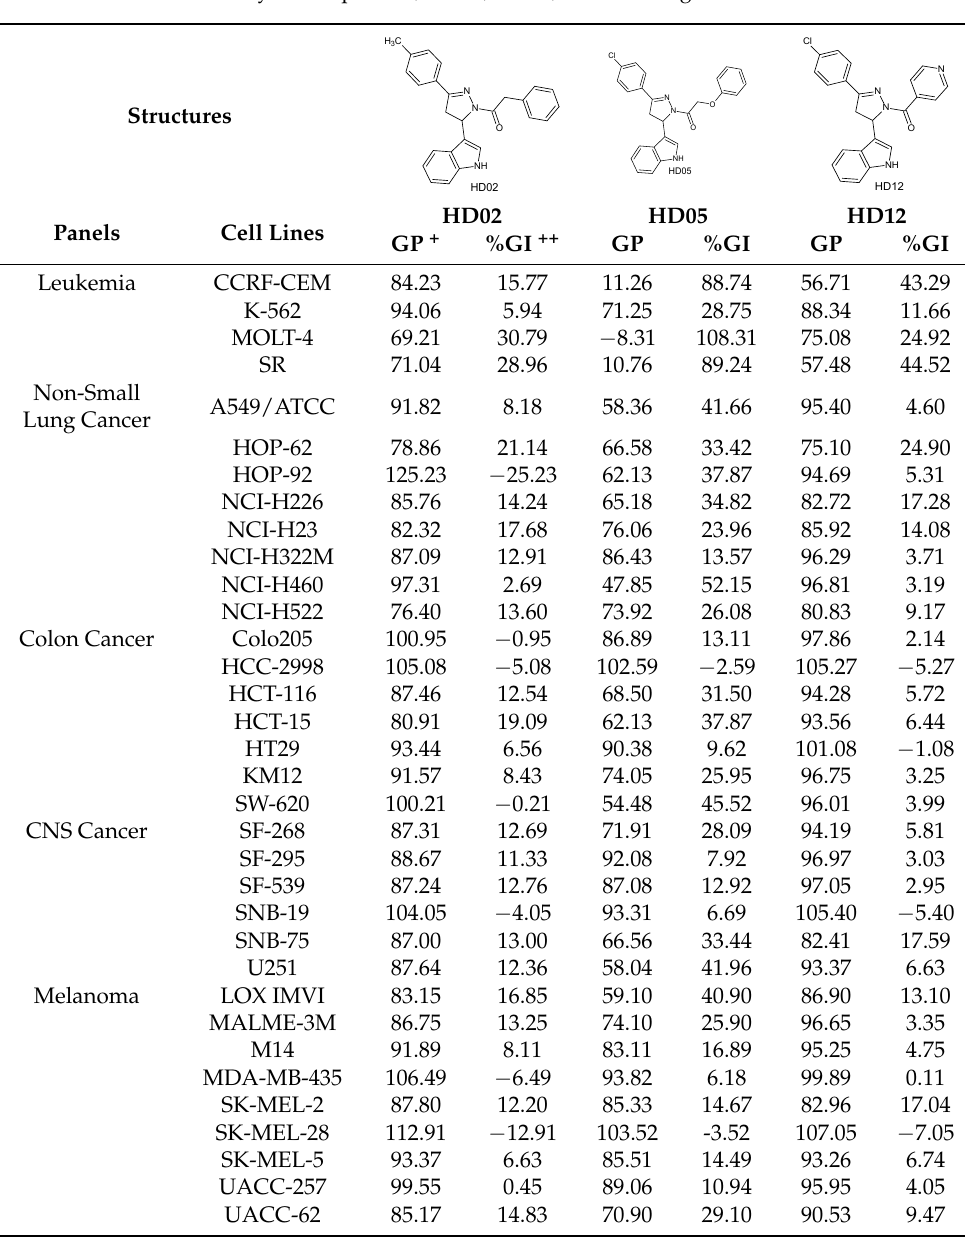
Table 2. Anti-cancer activity of compounds, HD02, HD05, and HD12 against 56 NCI cancer cell lines.